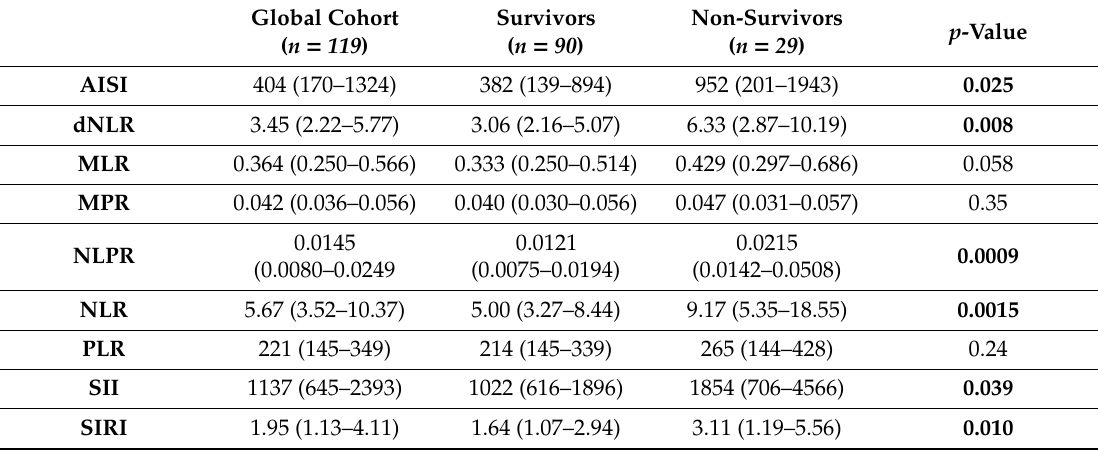
Table 2. Blood cell count-derived inflammation indexes of COVID-19 survivors and